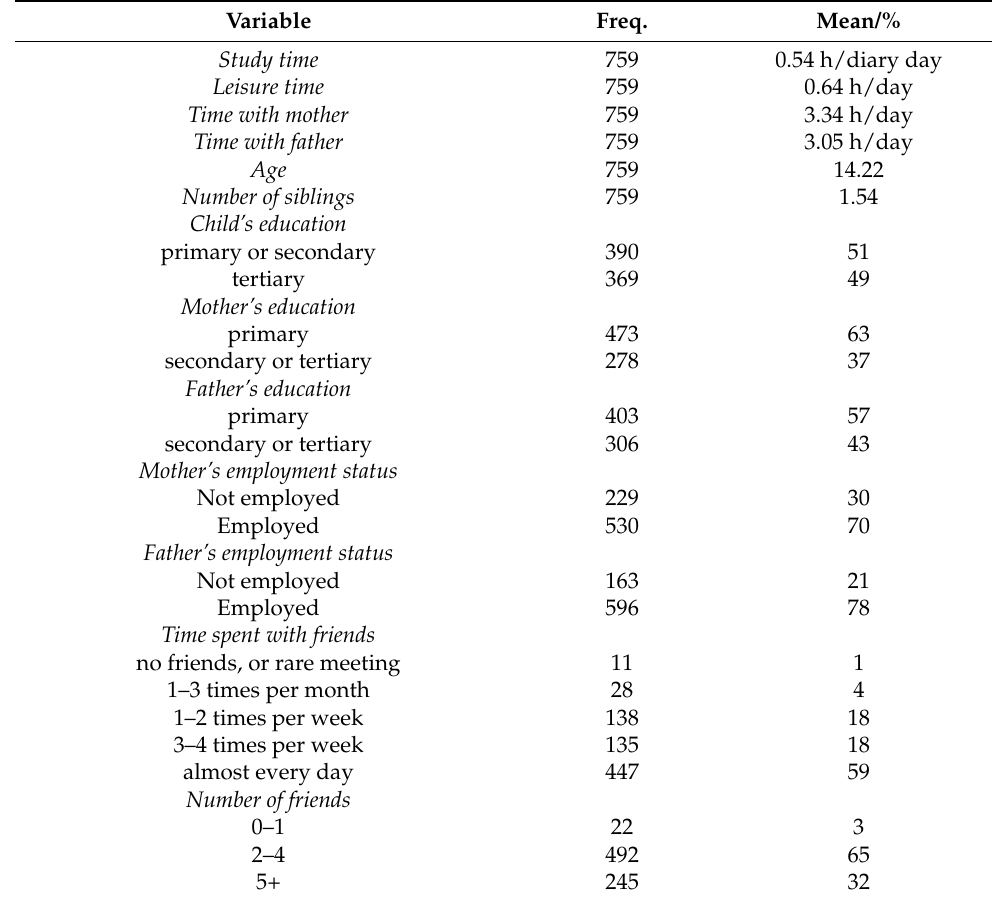
Table 1. Descriptive statistics. The Finnish Time Use Survey (FTUS) 1979 and population register data on education at the age of 40. Variable Freq.